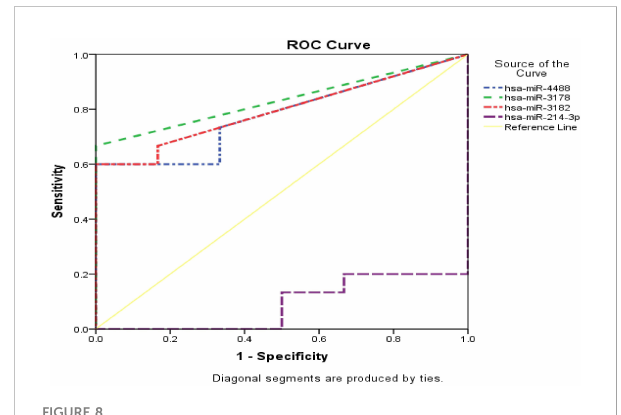
FIGURE 8 Combined ROC curve for unique miRNA both HCC group and control group. vertical axis represent sensitivity, for speci fi city horizontal axis was used. Yellow line represent reference, dotted lines with blue, green, red and violet colors represent miR-4488, miR-3178, miR-3182 and miR-214-3p